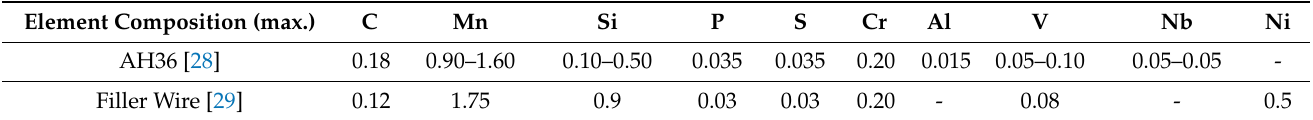
Table 1. Chemical composition (wt%) of the AH36 steel and filler